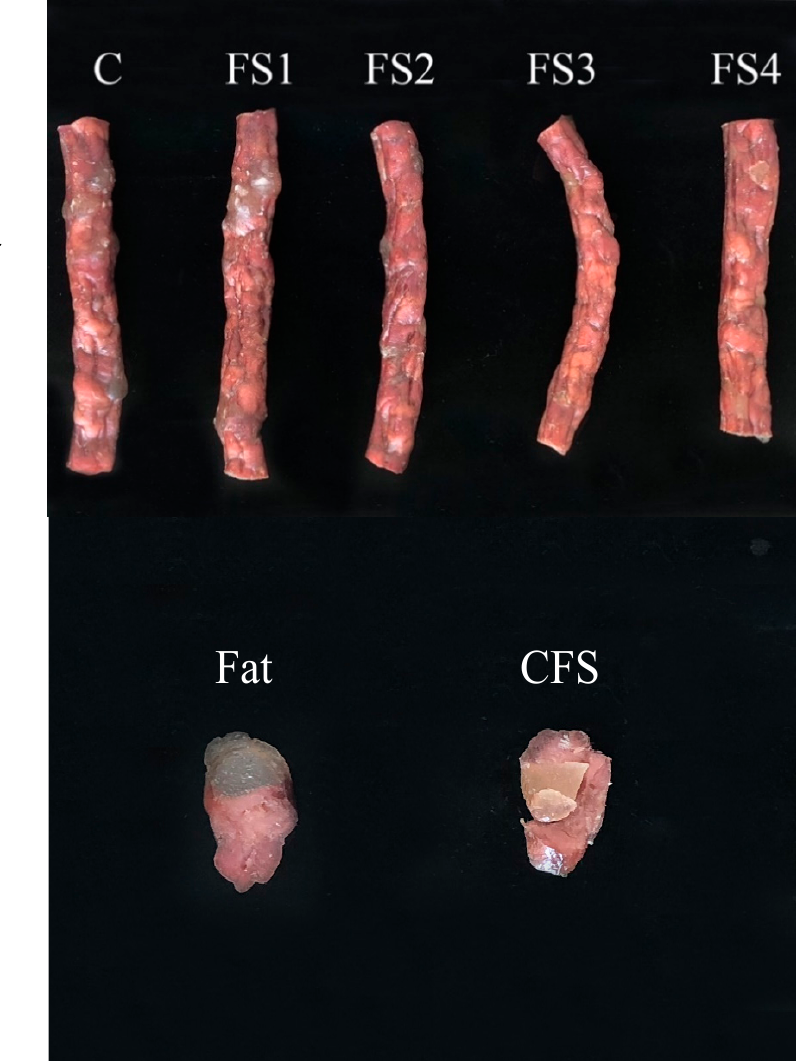
Figure 5. Appearance of the uncooked sausages, cooked sausages and slices of cooked sausages containing true fat and CFS.